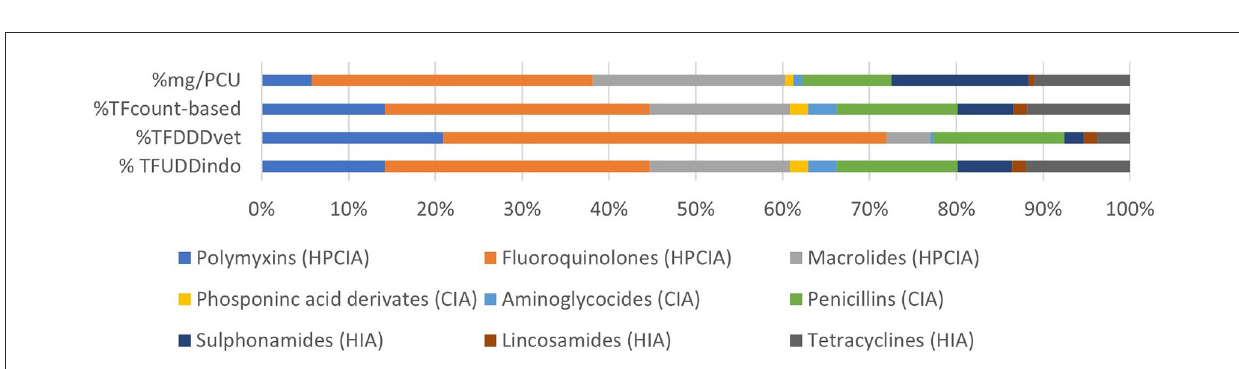
was 0.3 (SD: 0.3) and TF DDDvet was 0.6 (SD: 0.6). The mean TF count − based was 0.3 (SD